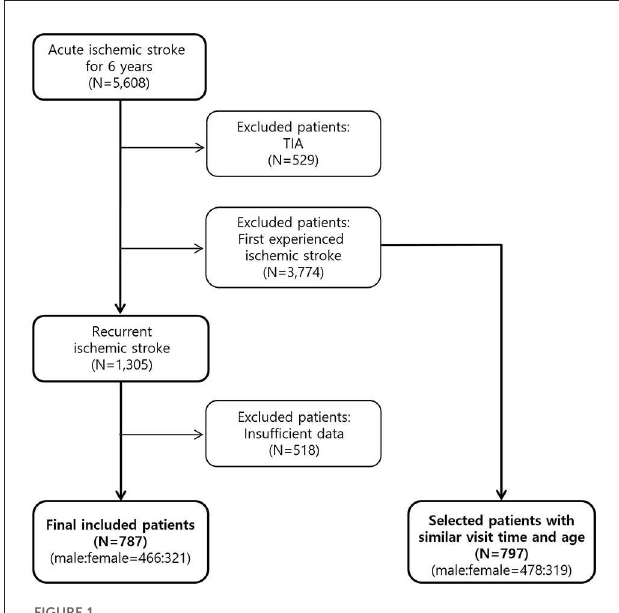
FIGURE1 Flow diagram of recurrent ischemic stroke patient selection. First onset patients were set as a control group and both groups were compared divided by male and